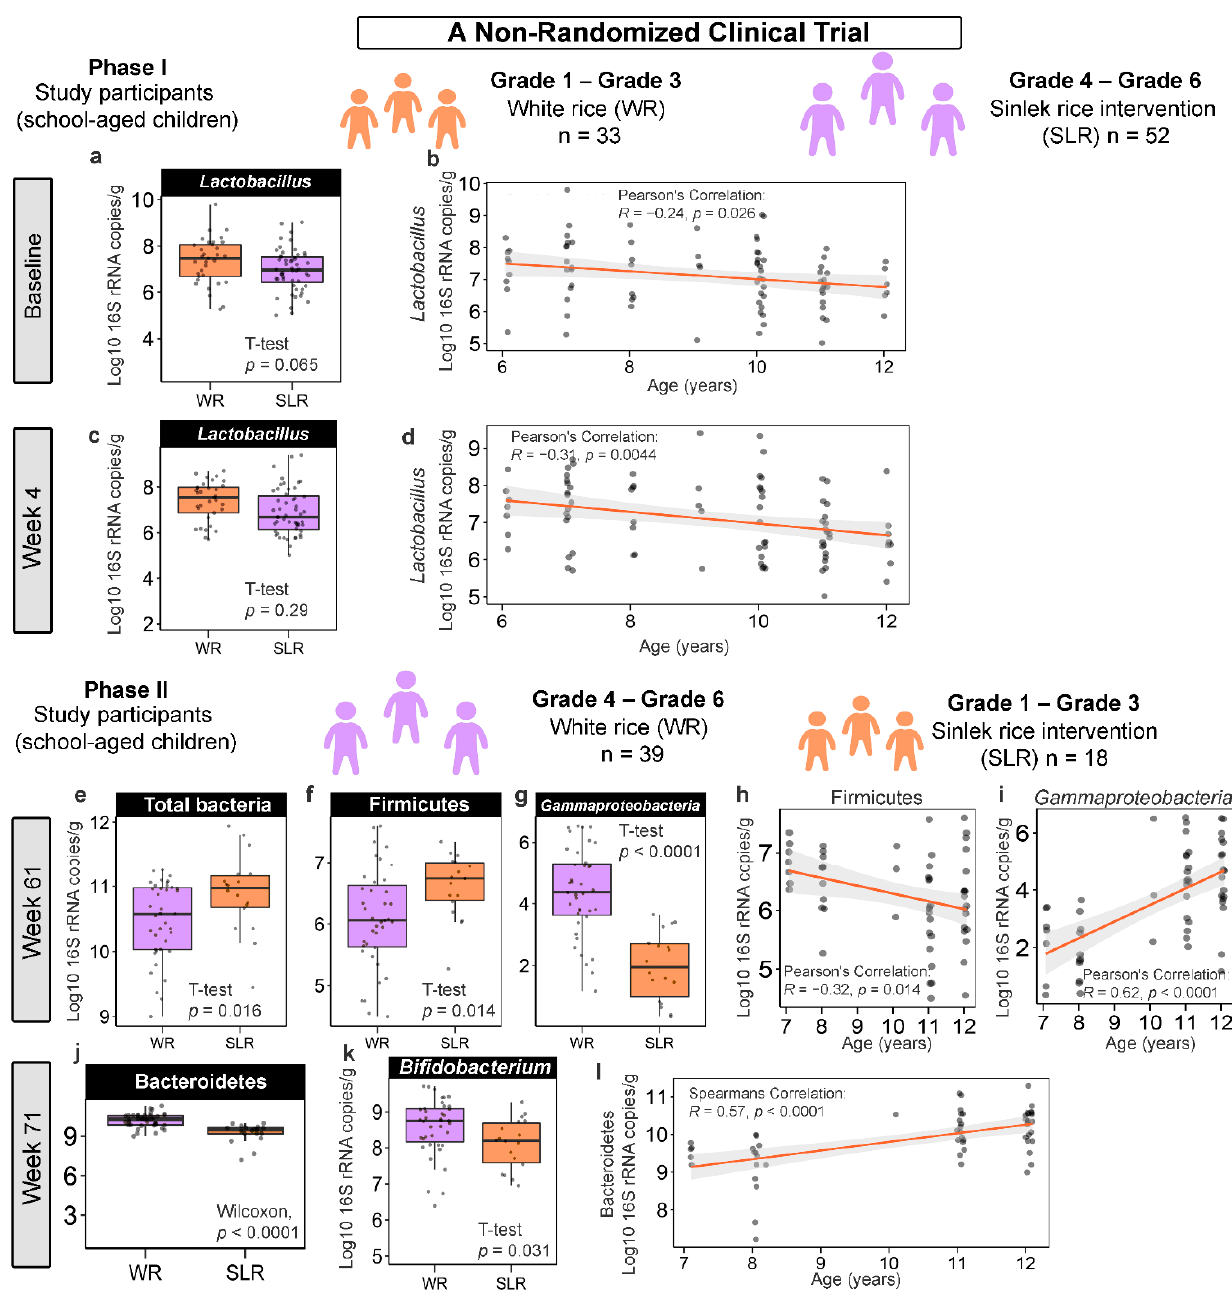
Figure 2. The ways in which Sinlek rice intervention affected the absolute abundance of gut micro- biota of school-aged children in a non-randomized clinical trial. ( a , c , e – g , j , k ) Boxplots representing the normalized bacterial abundances at the phylum, class, and genus levels based on log10 qPCR 16S rRNA copy number per gram of feces. A difference between the mean absolute abundances of the control (WR) and intervention (SLR) groups was determined using either the two-sample t -test or Wilcoxon rank sum test. No significant differences between the mean absolute abundances of gut microbiota of the control and intervention groups at Week 15 (Phase I) and Week 56 (Phase II) were detected. ( b , d , h , i , l ) Associations between the absolute abundances of gut microbiota and age of school-aged children were determined using either the Pearson’s or Spearman’s rank correlation coefficient. WR, white rice (control); SLR, Sinlek rice intervention.